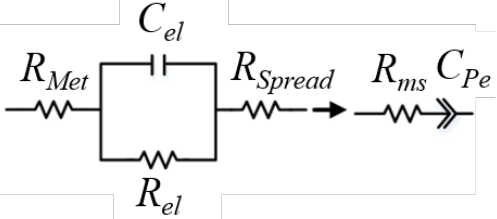
Figure 6. Schematic circuit of the electrolyte and electrode interface.